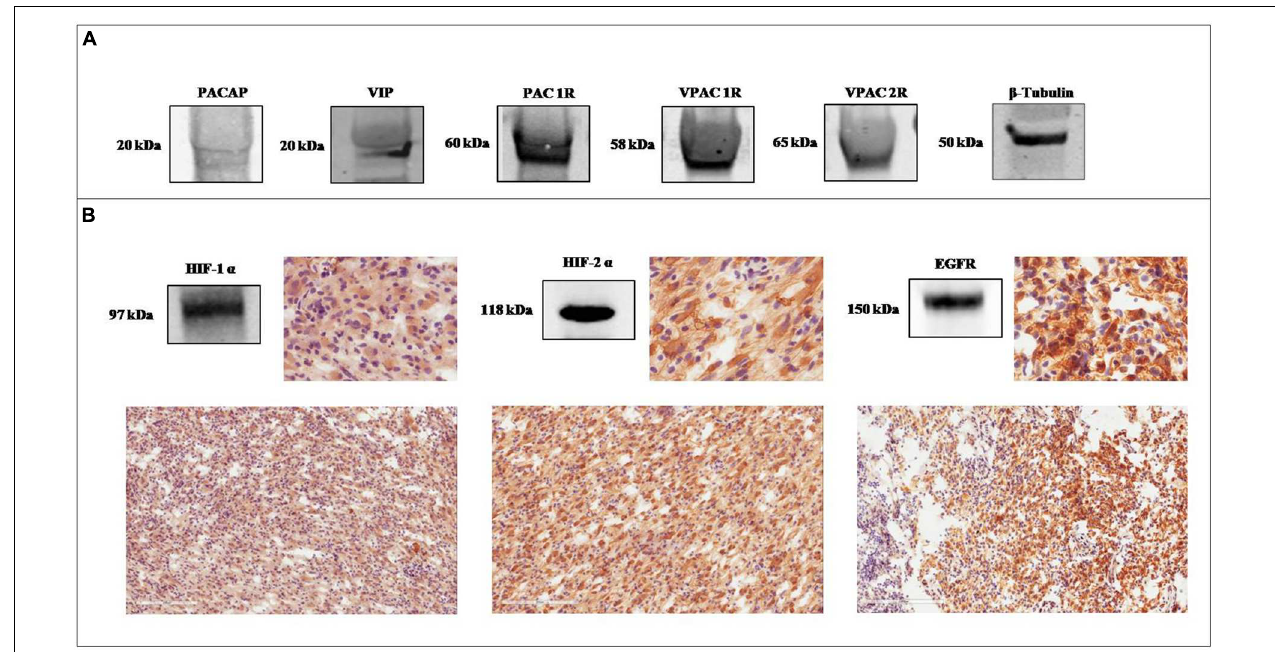
FIGURE 1 | Expression of PACAP, VIP, VIPRs, HIF-1 α , HIF-2 α , and EGFR in glioblastoma multiforme (GBM). (A) Representative immunoblot of PACAP and VIP precursor peptides and PAC1R, VPAC1R, and VPAC2R expression on frozen glioblastoma sample. (B) Representative immunoblot and photomicrographs of signals detected by antibodies direct against HIF-1 α , HIF-2 α , and EGFR in a frozen glioblastoma sample.